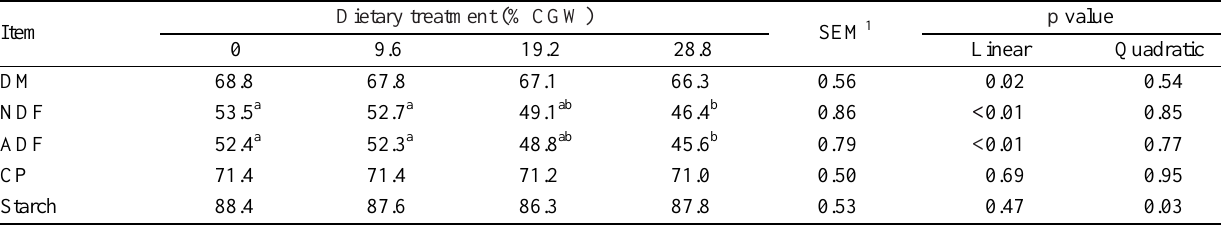
Table 2. Effect of replacing dietary GC with CGW on total tract nutrient digestibility in dairy cows (%)